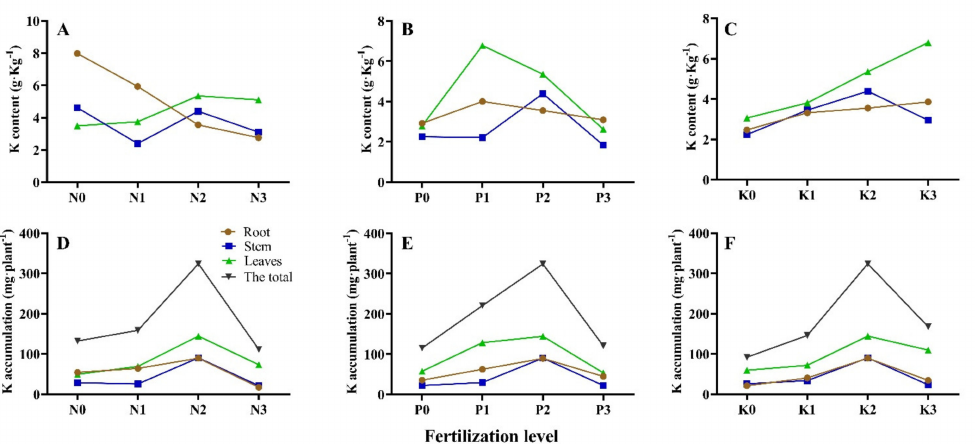
Figure 6. Changes of K content and accumulation in P. bournei seedlings under the single-factor of N, P, and K fertilizer. ( A , D ): the single-factor of N fertilizer; ( B , E ): the single-factor of P fertilizer; ( C , F ): the single-factor of K